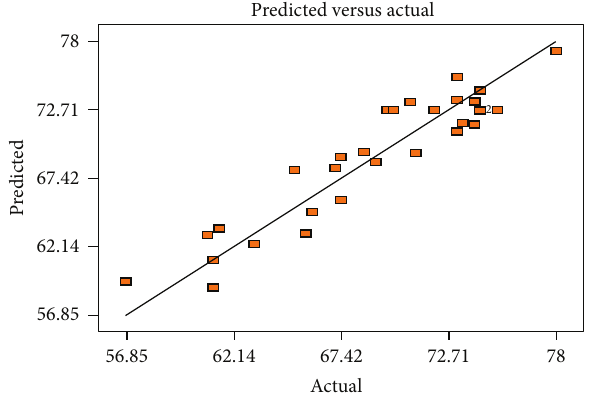
Figure 5: Plot of the predicted versus actual COD removal.